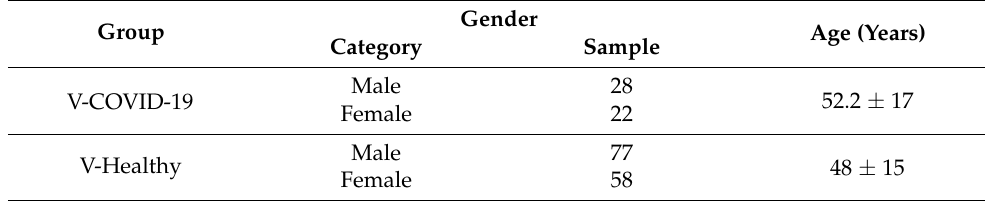
Table 1. Information of the population.